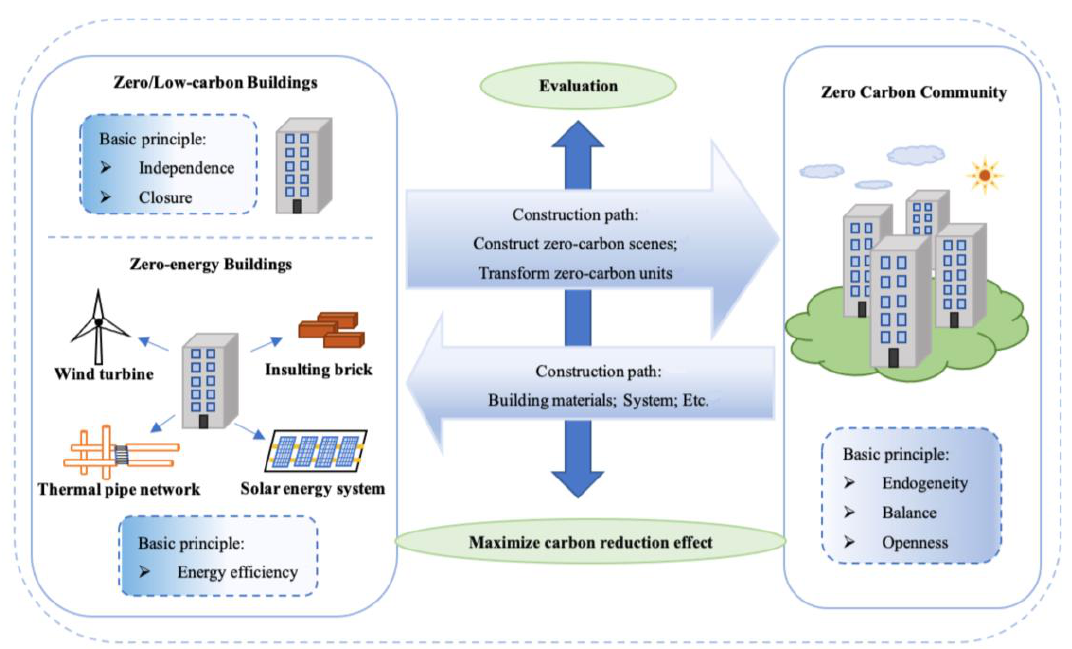
Figure 1. Relationship and difference between zero/low-carbon buildings, zero-energy buildings and zero-carbon community.